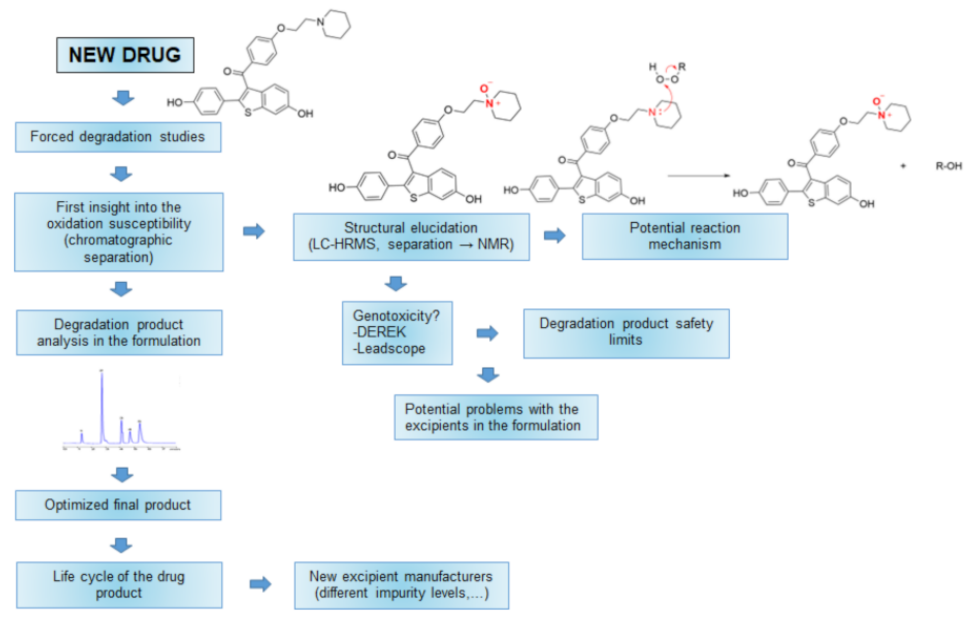
Figure 1. Schematic representation of oxidation reactions and their role through drug development. Of note, in this review the word “drug” corresponds to “active pharmaceutical ingredient” and not to “final drug